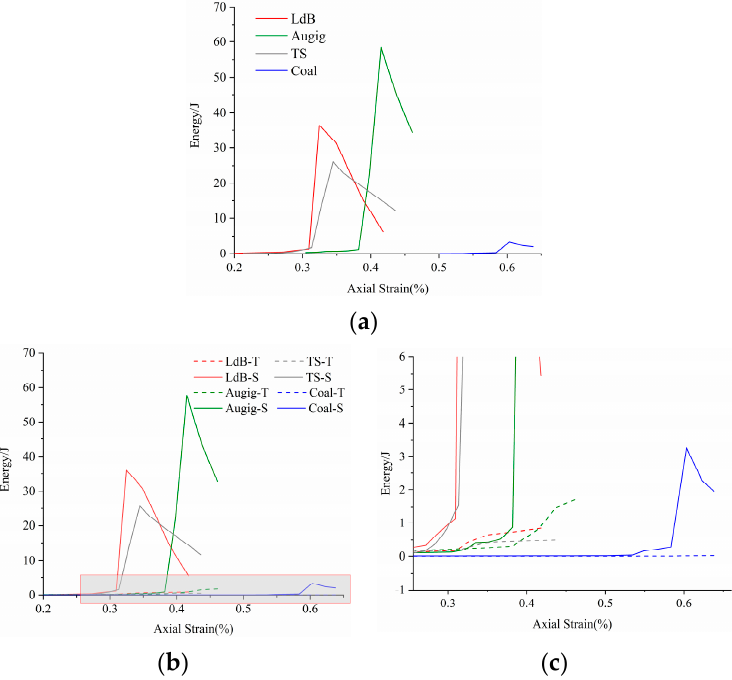
Figure 11. Energy accumulation and dissipation of four rock samples. ( a ) Energy change curve; ( b ) tensile crack(-T) and shear crack(-S) energy change curve; ( c ) locally enlarged view for tensile crack energy change curve.